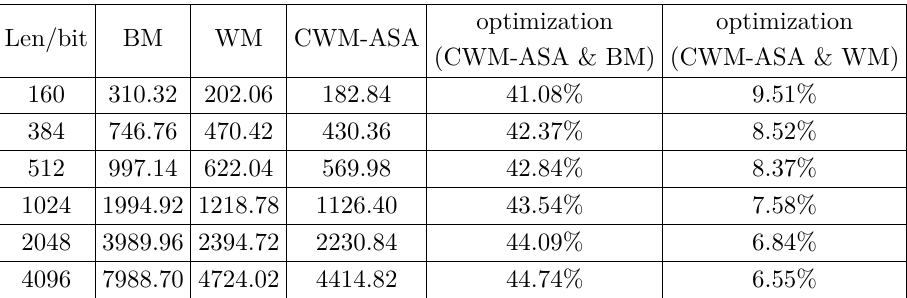
Table 3: Comparison of CWM-ASA and BM, WM when p = 0 . 95.